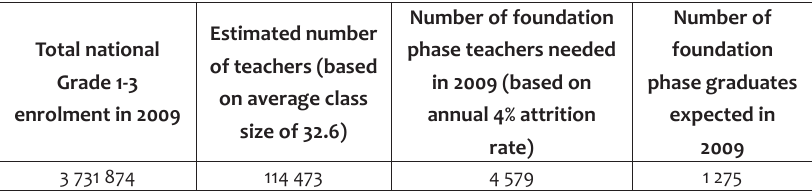
Table 2: National foundation phase teacher provision and demand in 2009